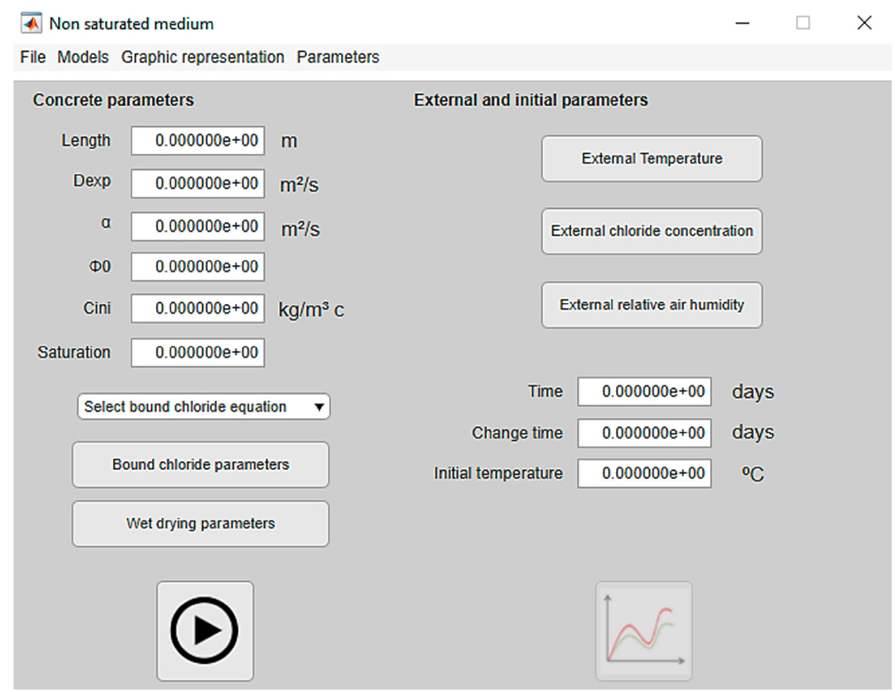
Figure 7. Screen of input data for unsaturated problem.